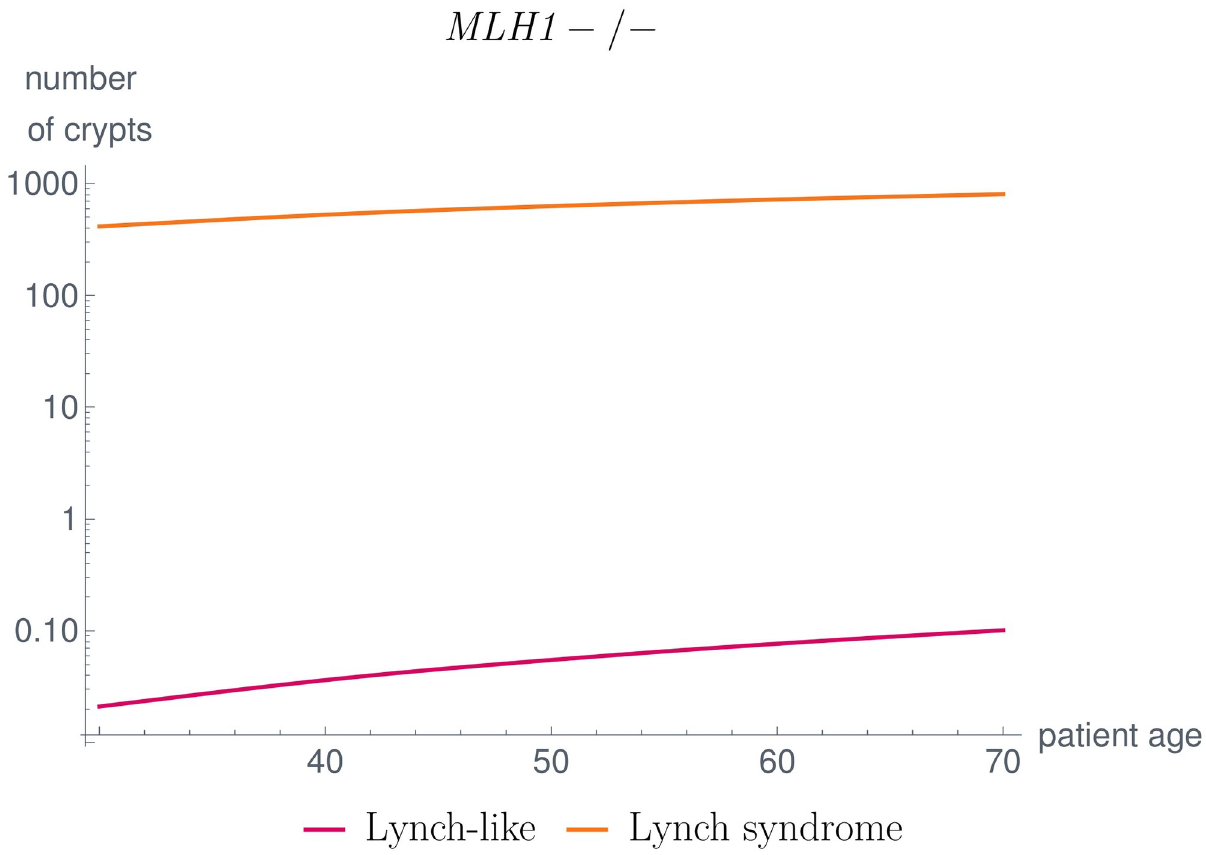
Fig 12. Comparison of MMR-deficient crypts in Lynch-like and Lynch syndrome individuals. The number of MMR-deficient crypts is significantly higher in Lynch syndrome individuals compared to Lynch-like individuals, which matches the findings in [80].